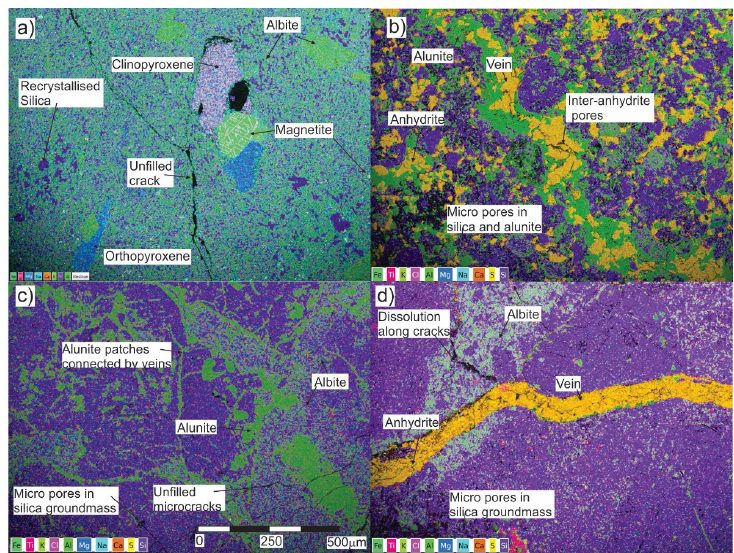
Figure 3. Scanning Electron Microscopy EDS (Energy Dispersive X-ray Spectroscopy) element maps of ( a ) relatively unaltered lava; ( b ) altered lava; ( c ) altered lava; ( d ) altered lava. Note that the scale of each image is the same as in (c). Table 1. X-ray diffraction data for the samples studied.